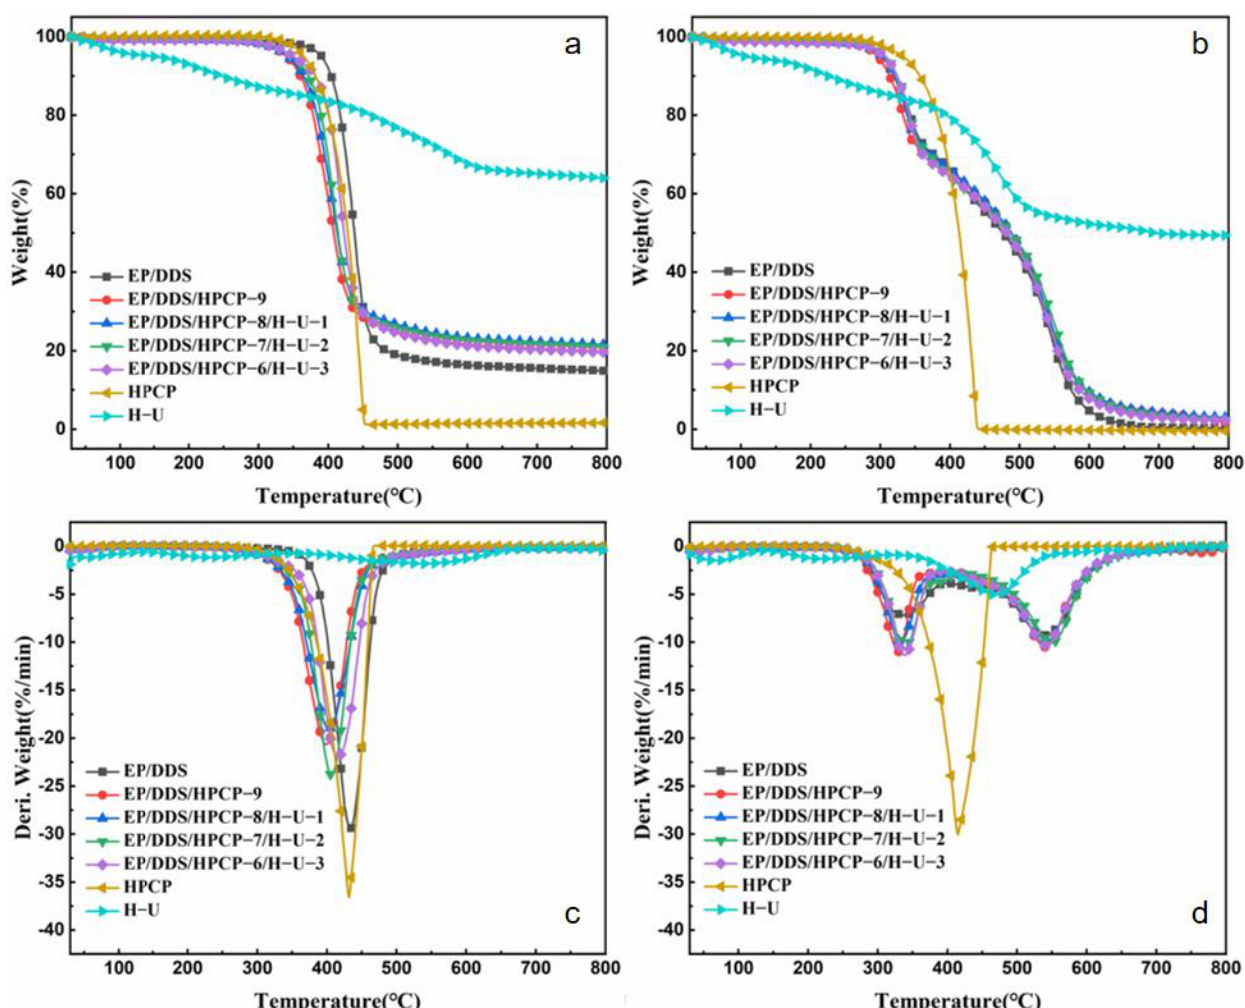
Figure 5. TG and DTG plots of EP samples, H − U and HPCP in N 2 ( a , c ) and air ( b , d ) conditions. Table 2. TGA results of EP and its composites.